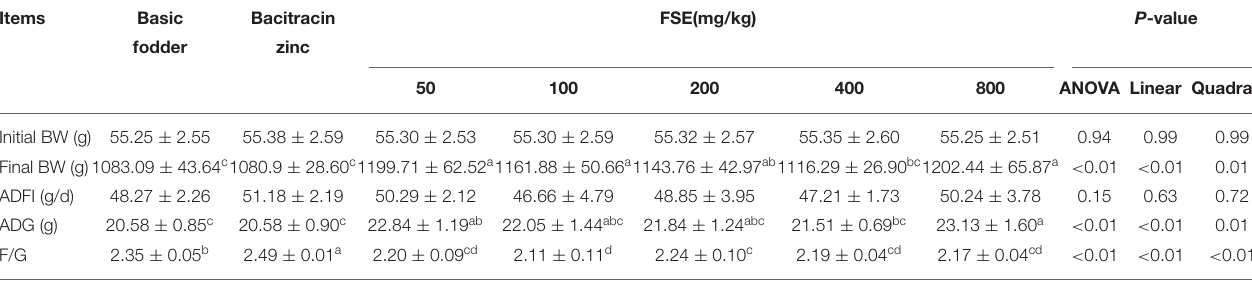
TABLE 4 | Effect of fenugreek seed extract on growth performance of broilers 1 . Items